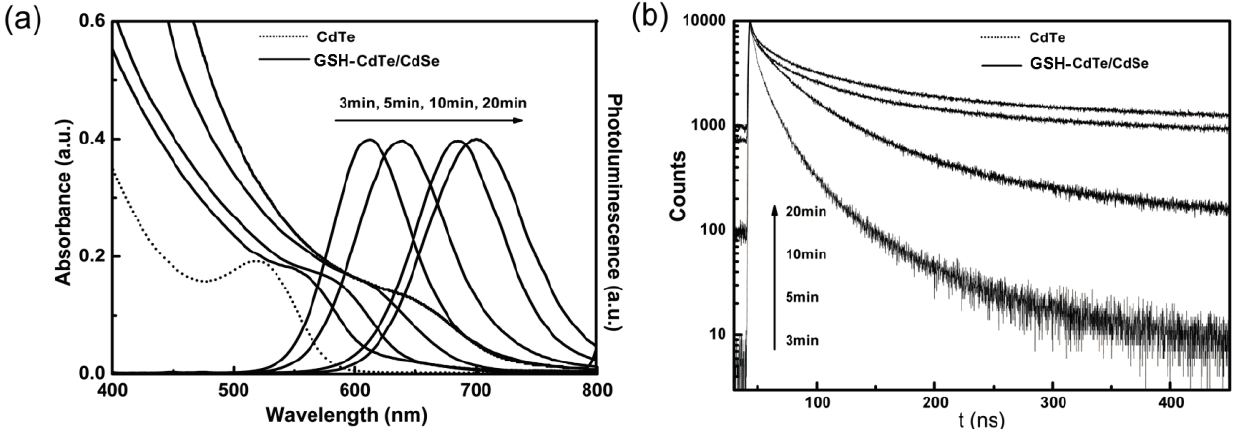
Figure 3. ( a ) UV–Vis and Photoluminescence spectra of CdTe (dashed line) and GSH-CdTe/CdSe QDs with different shell thickness (solid lines); ( b ) Fluorescence decay curves of a CdTe core (dashed line) and GSH-CdTe/CdSe QDs with different shell thickness (solid